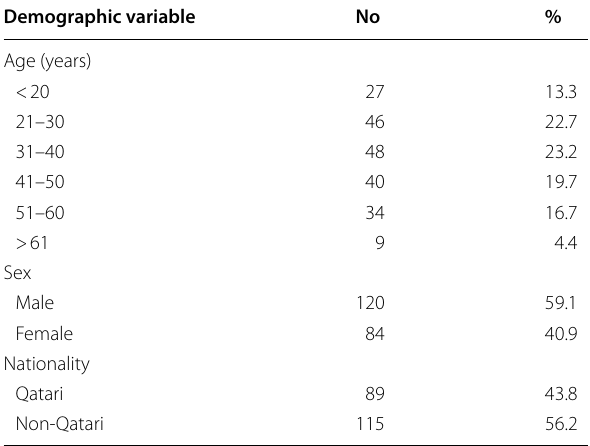
Table 2 Demographic variables of patients with positive